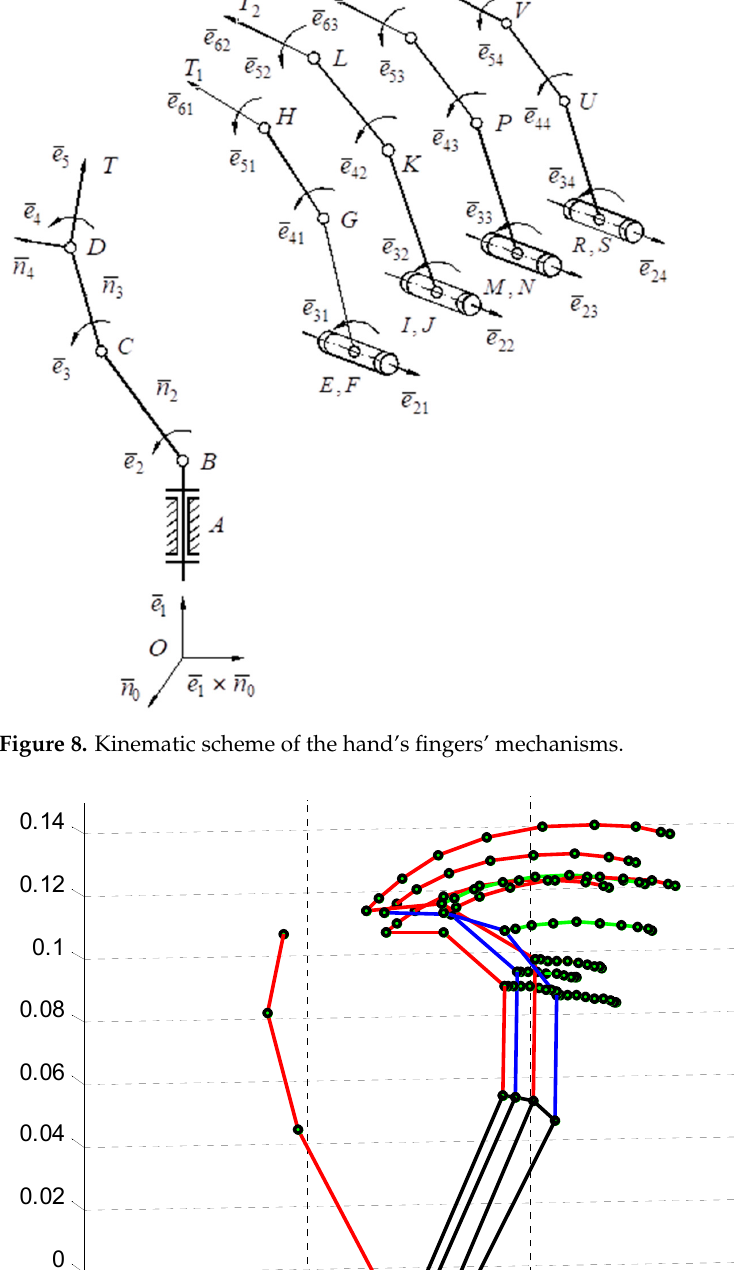
Figure 10. Index finger mechanism. The mechanism is of triad structure, with B, E, and G being the input joints, and C, D, and F being the interior joints (Figure 11). For the index finger model, the kinetostatic calculation was done with Matlab software, assuming that each of the loading forces, 𝑄 (cid:3036) (i = 1, 2, 3), are about 20 N (estimated value based on experiments with grasping relatively small objects). The simulation results are presented in Figure 12.